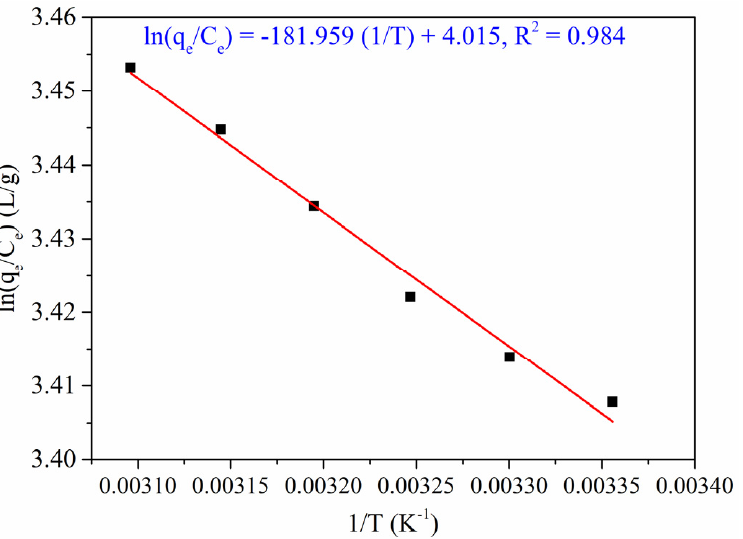
Figure 9. Thermodynamic study for RO16 removal by Cu(I)-PANI adsorption (initial concentration, pH, dosage, contact time, and volume of solution are 100 mg/L, 4, 0.06 g/L, 100 min, and 100 mL, respectively). Table 3. Thermodynamic adsorption parameters of RO16 dye by Cu(I)-PANI at different temperatures. Temp